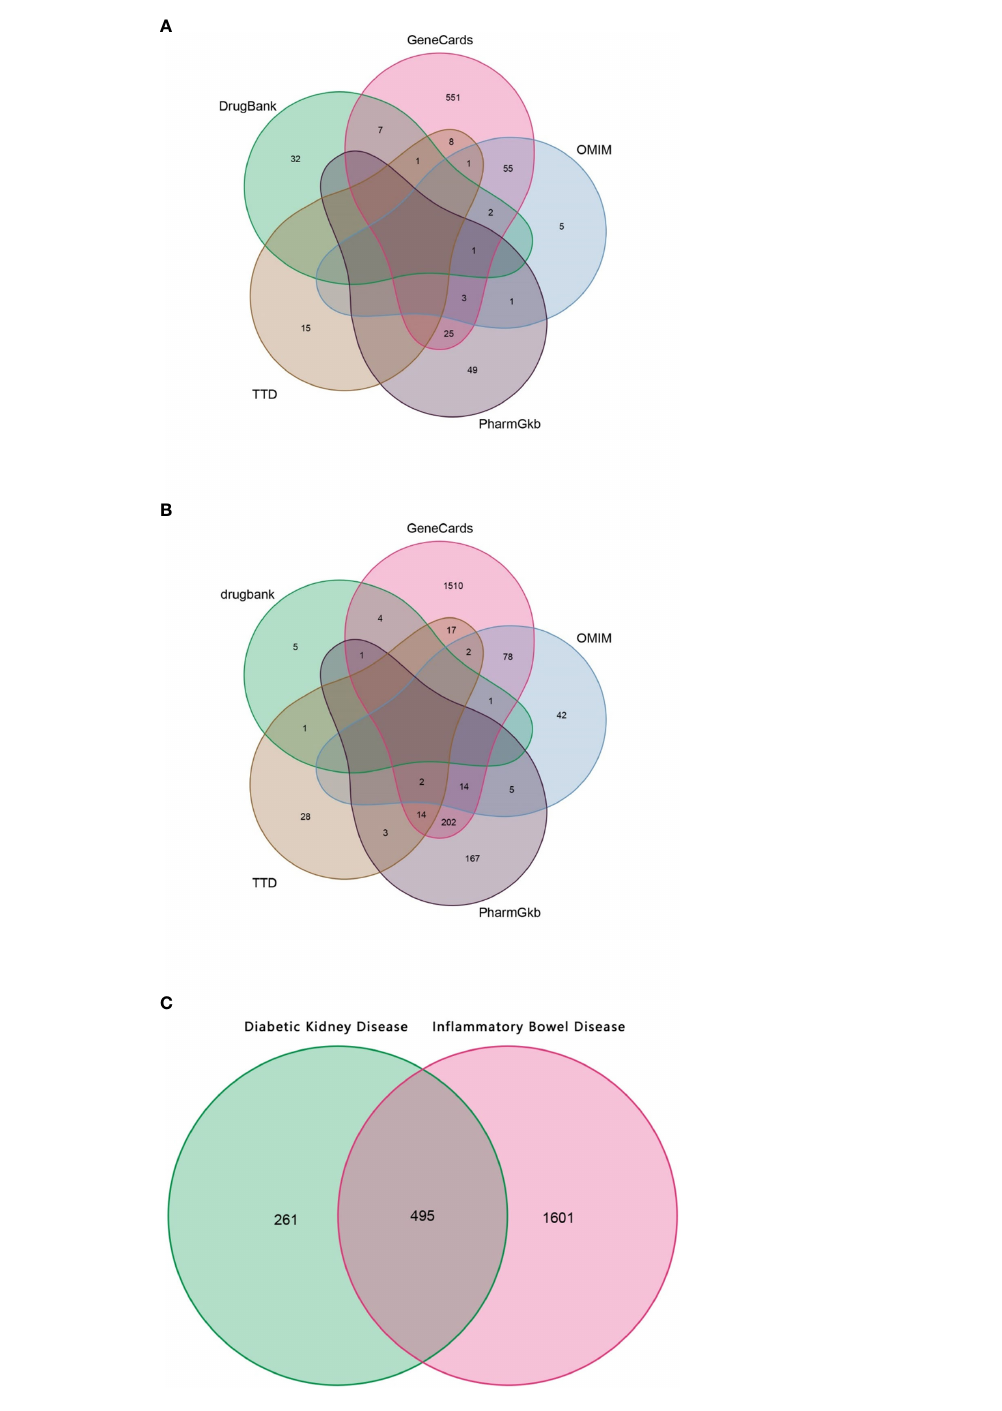
FIGURE 2 The Venn diagram. (A) Collection of gene targets associated with DKD from databases. (B) Collection of gene targets associated with IBD from databases. (C) Identi fi cation of the possible risk genes of DKD complicated with